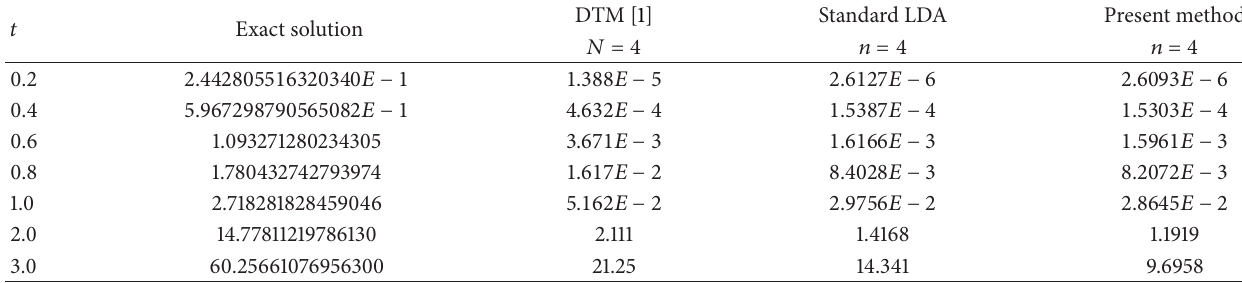
Table 3: Comparison of the absolute errors for Example 3.